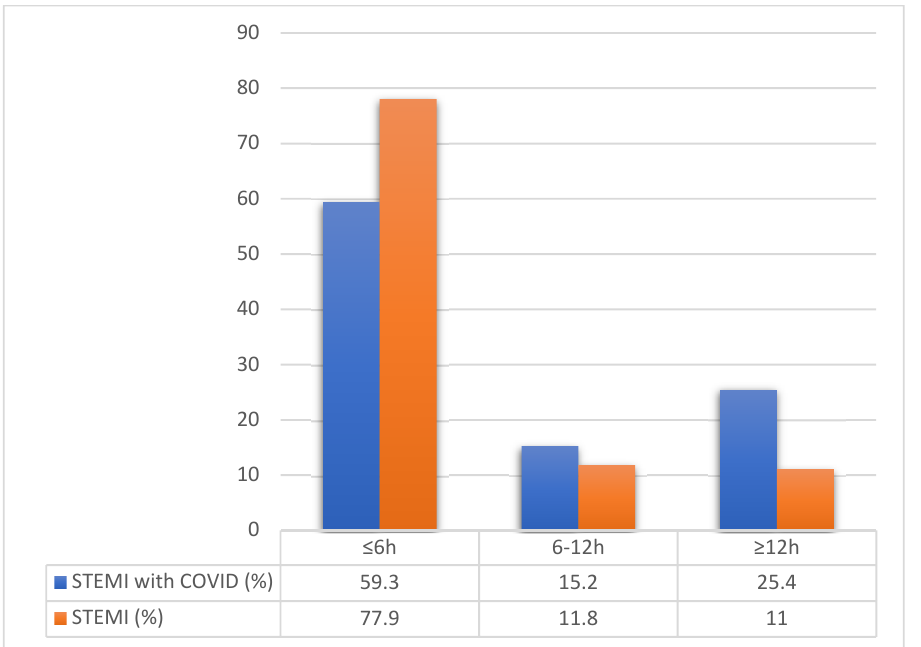
Figure 1. Time from symptoms onset until hospitalization compared between STEMI groups. Legend: STEMI—ST elevated myocardial infarction, COVID—Coronavirus disease. Table 5. Laboratory findings for STEMI